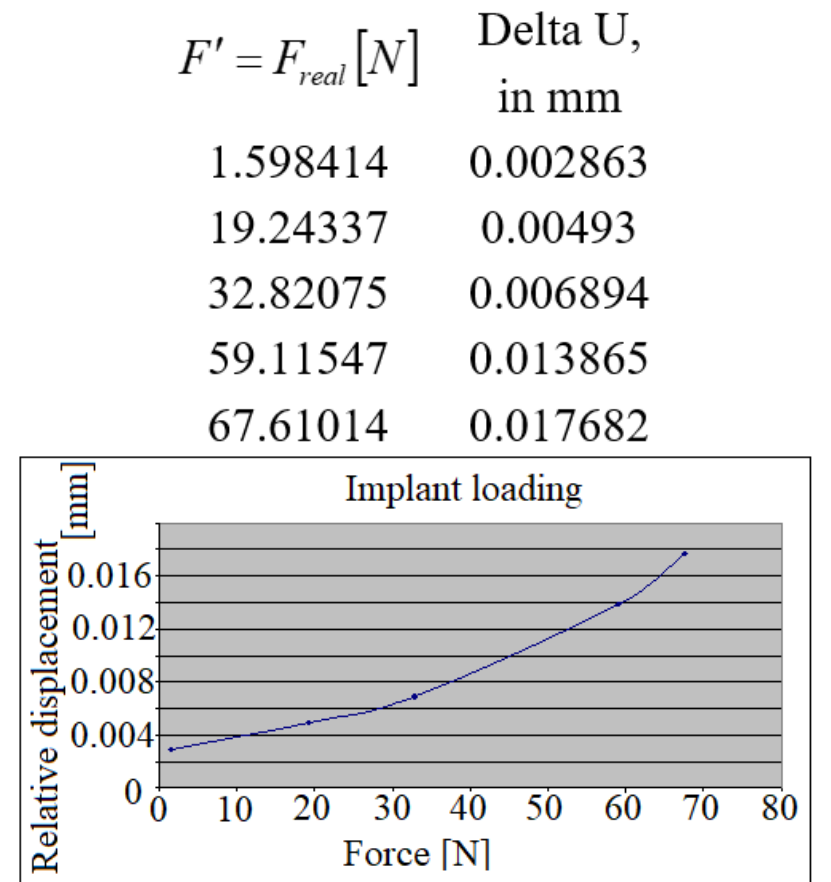
Figure 7. The relative displacements of the crowns during the implant’s loading. 2) Case of the mesial tooth loading with increasing masticator forces Based on similar analysis, a characteristic masticator cycle has been identified, resulting in the diagram shown in Figure 8, representing the displacements in the axis of the loaded natural tooth crown.